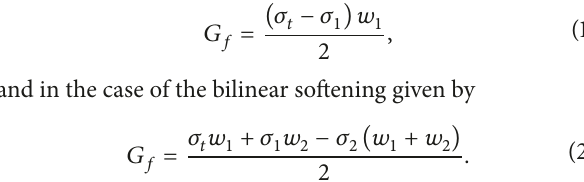
∗ Analysed using FE